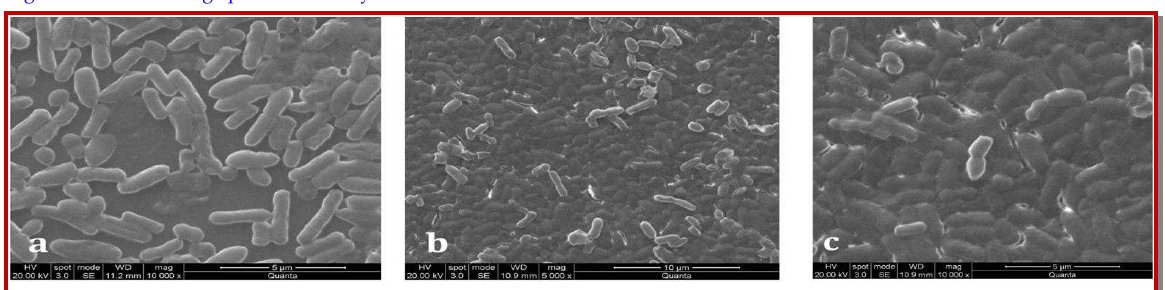
EA: Ethy1 acetate extract MeOH: Methanol extract Acet: Acetone Figure 2: DNA breakage protection assay